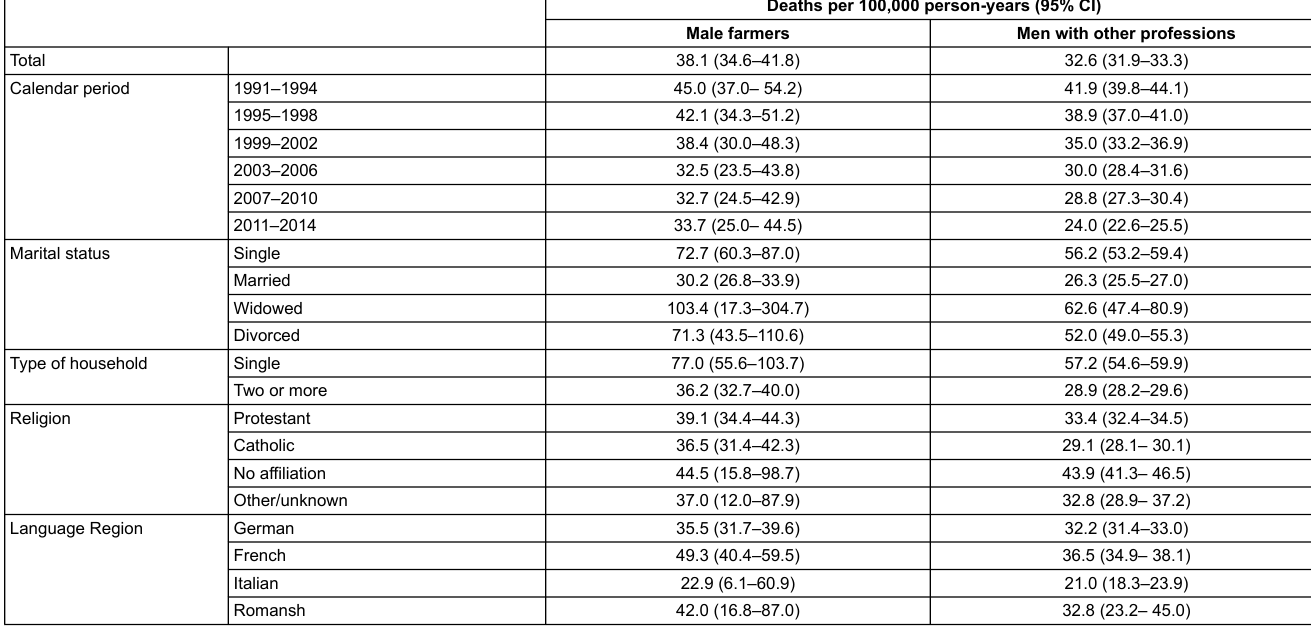
Table 2: Age-standardised rates * of suicide in male farmers and men with other professions included in the study.